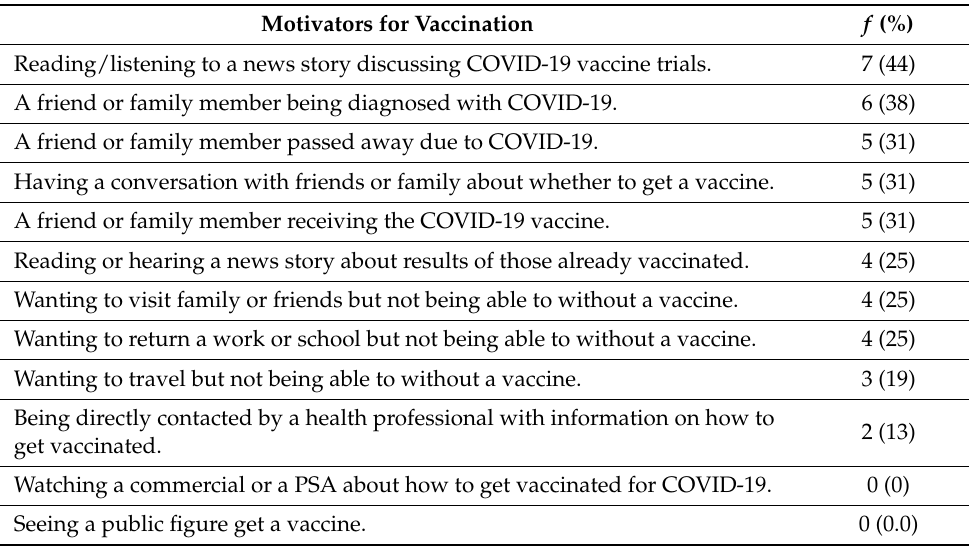
Table 3. Self-reported motivations for COVID-19 vaccination among the vaccinated participants ( n =